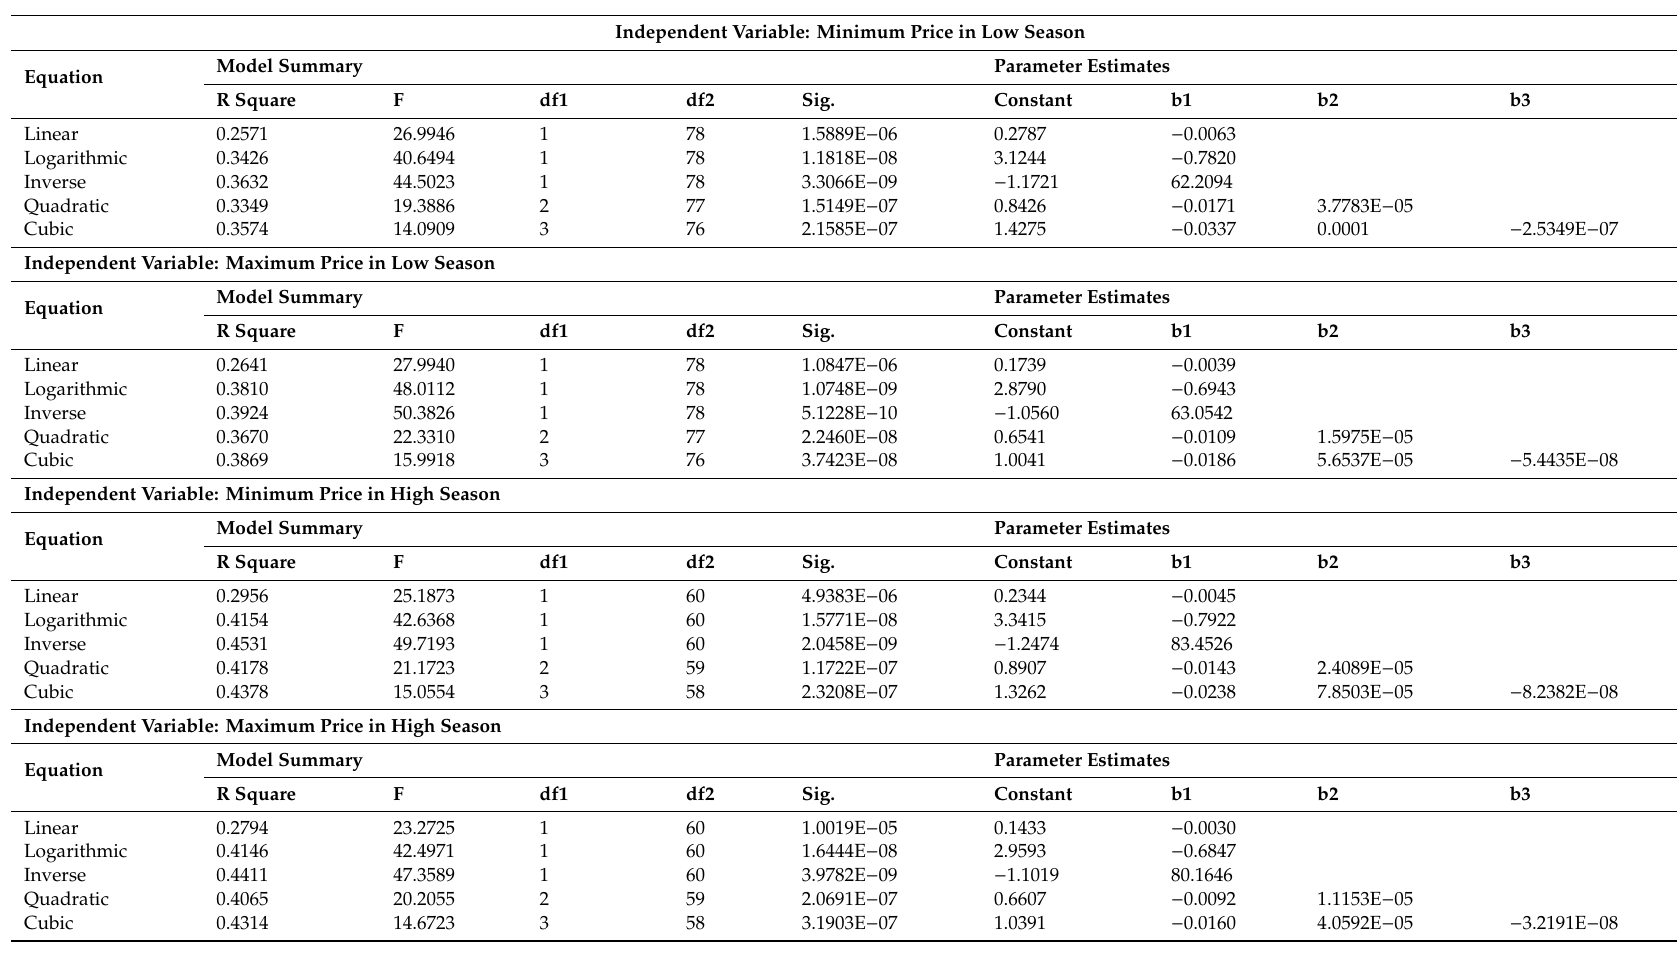
Table 10. Model summary and parameter estimates of regression analysis in Tenerife destination with added value as dependent